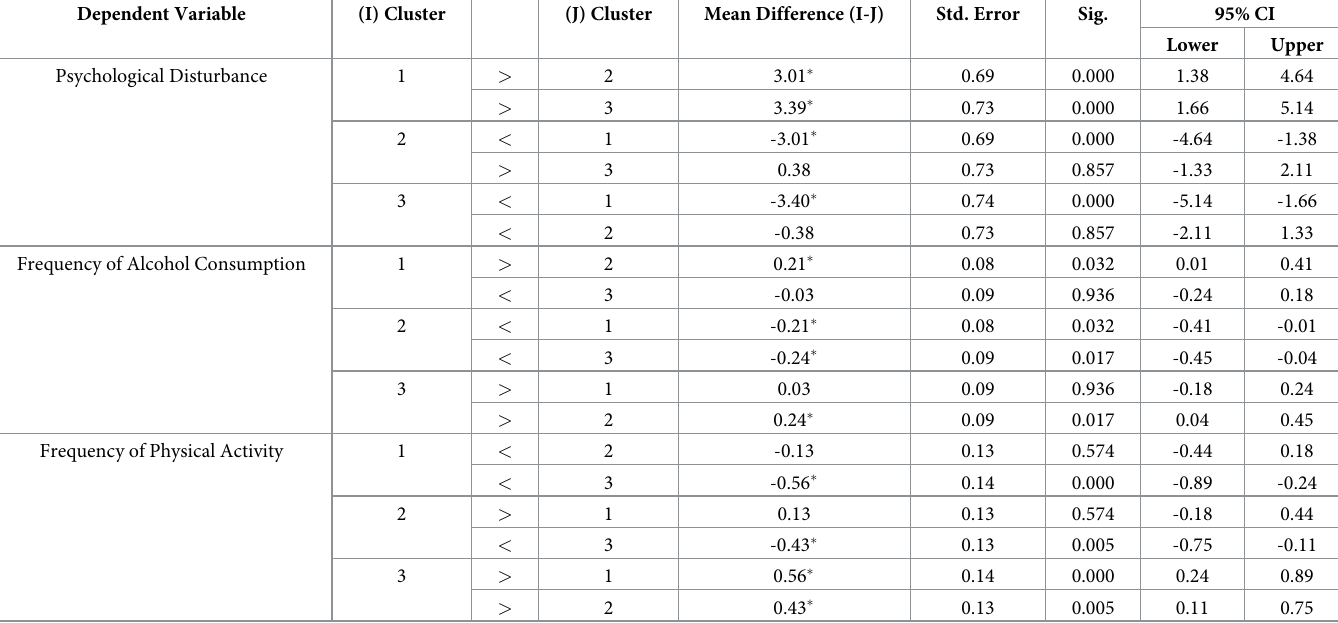
Table 4. Multiple comparisons (Tukey HSD). Factor: Two Step Cluster (Model A).